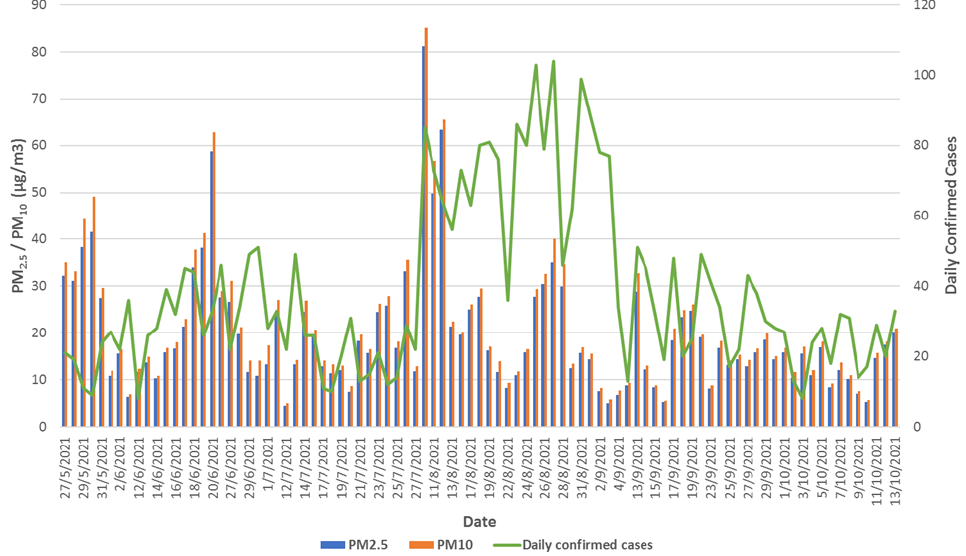
Figure 3. Indoor PM 2.5 and PM 10 daily mean concentrations and COVID-19 confirmed